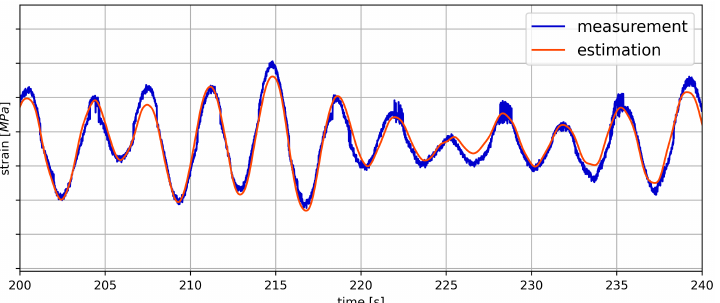
Figure 2. An example of a polluted measurement compared to the virtual sensing strain estimate. The noisy peaks and sudden discrete jumps in strain are the result of the FBG reading jumping between two